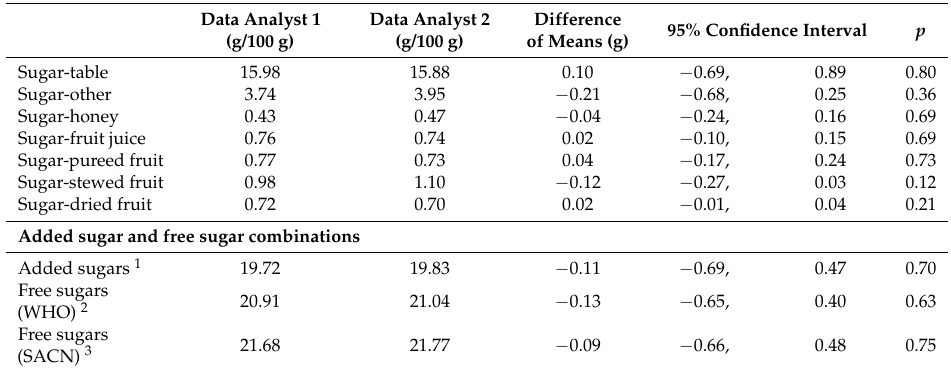
Table 1. Inter-rater repeatability test results; the comparison of mean values between two data analysts using paired t -test ( n =